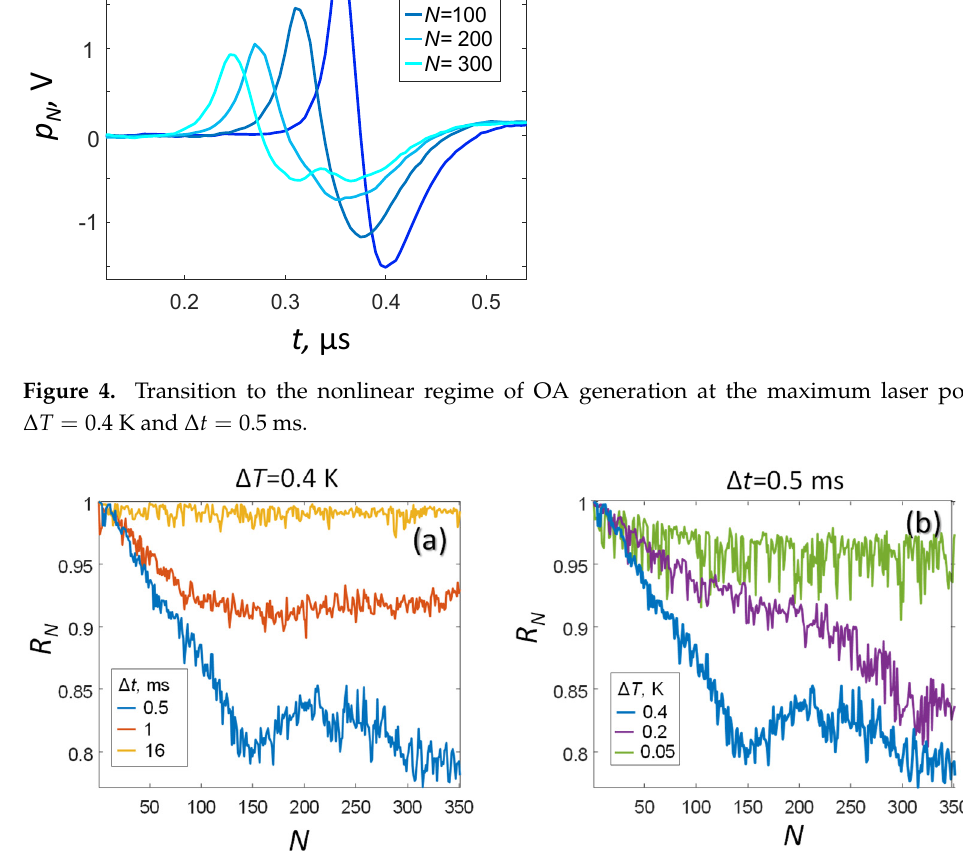
Figure 6. Methods of quantitative OA measurements by means of: ( a ) exponential interpolation, ( b ) differentiation, ( c ) integration of the measured OA signal. To calculate the optical absorption coefficient of oil (cid:2020) (cid:3028) (cid:3015) at room temperature, it was convenient to use the maximum laser power regime ( Δ(cid:1872) = 0.5 ms, Δ(cid:1846) = 0.4 K), achieving the maximum signal-to-noise ratio (Figure 5) by averaging the first (cid:1840) = 50 measured OA pulses ( (cid:1844) (cid:3015) > 0.95 ). The results of substitution of the corresponding averaged values 〈(cid:1868) (cid:3015) ((cid:2028))〉 (cid:3015)(cid:2880)(cid:2869)..(cid:2873)(cid:2868) in formulas (15)–(20) are shown in Figure 6. It is easy to see that the (cid:2020) (cid:3028) (cid:3015)